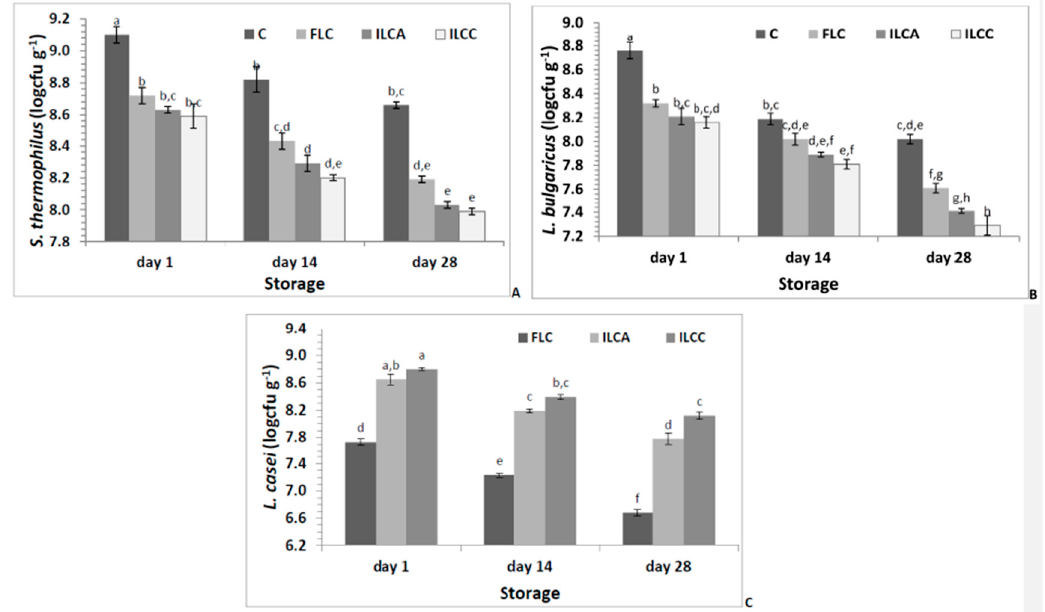
Figure 2. Viability of microorganisms used in yogurt production during refrigerated storage; A . Streptococcus thermophilus , B . Lactobacillus delbrueckii subsp. bulgaricus , C . Lactobacillus casei ATCC 393. (C = Yogurt produced with CH-1 culture; FLC = yogurt produced with freeze-dried free L. casei ATCC 393 cells and CH-1 culture; ILCA = yogurt produced with freeze-dried immobilized L. casei ATCC 393 cells on apple pieces and CH-1 culture; ILCC = yogurt produced with freeze-dried immobilized L. casei ATCC 393 cells on casein and CH-1 culture. Different letters in the columns indicate significant differences ( p < 0.05)).